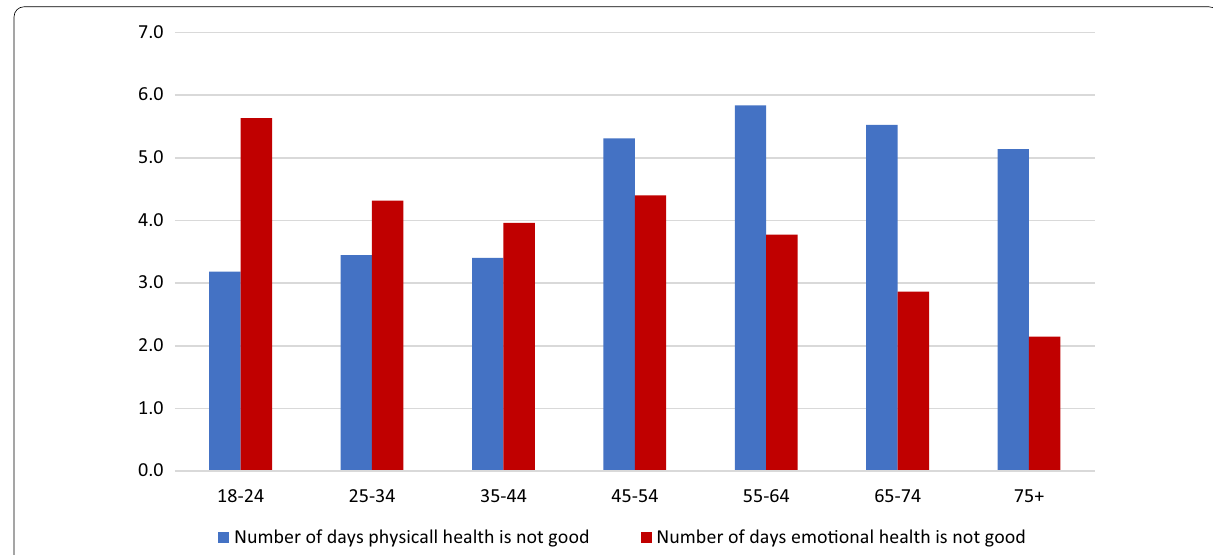
Fig. 1 Average number of days when physical/emotional health is not good by age